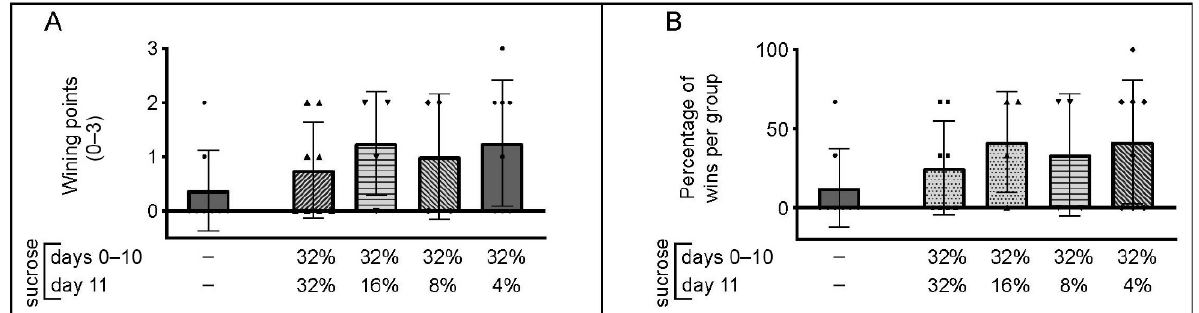
Figure 6. Changes in behavior of adult male C57BL/6J mice in the social confrontation tube test associated with ad libitum access to sucrose solution(s). The data are represented as mean ± SD, with individual data plots along column bars (8 animals per group in all except in 32% → 16 % and 32% → 8% downshifted groups which have 4 animals per group). Panel ( A ) represents the number of wins (out of three encounters). Panel ( B ) represents the same data expressed as percentage of wins per group. No significant differences between groups are observed.